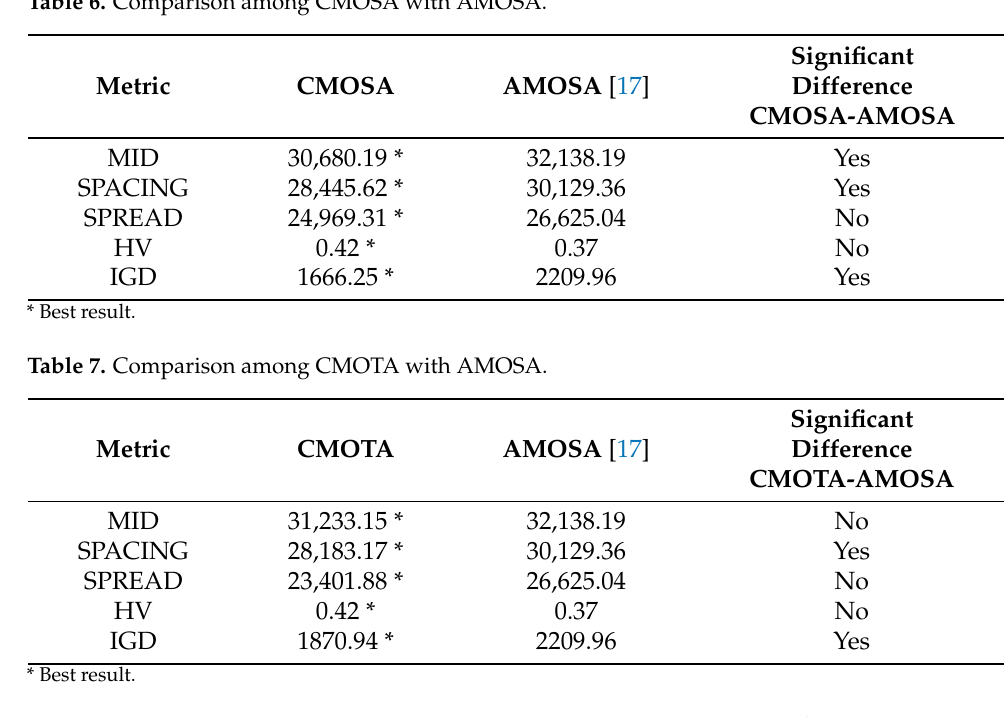
Table 6. Comparison among CMOSA with AMOSA.